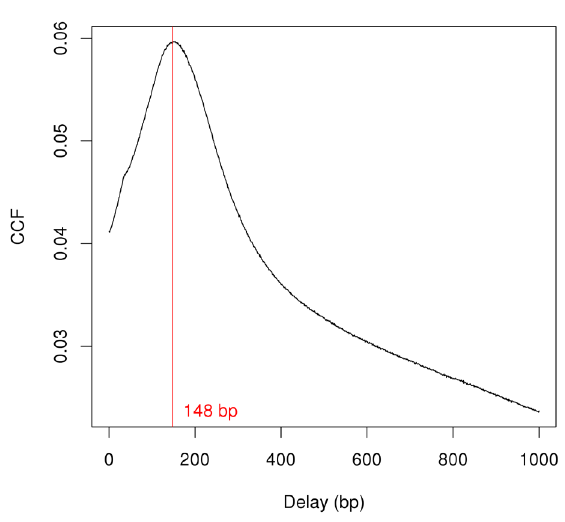
Figure 1. Cross-correlation function (CCF) against delay distance for the H3k9ac data set. The delay with the maximum correlation is shown as the red